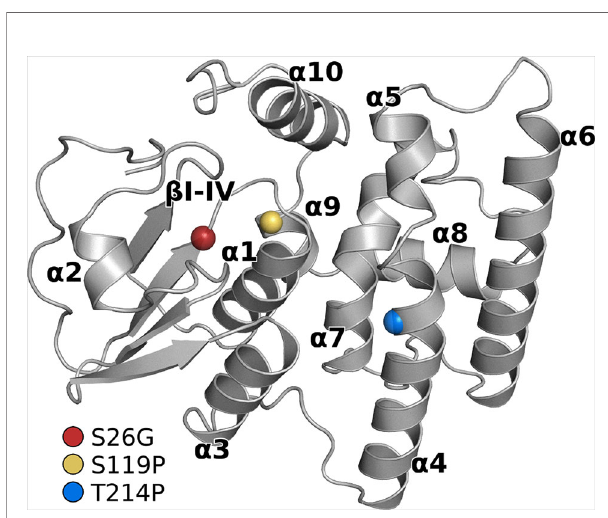
FIGURE 6 | Structure of the GSTO-1 homology model with labeled secondary structure elements. Colored spheres show the position of each punctual variant: red (S26G), yellow (S119P), blue (T214P).